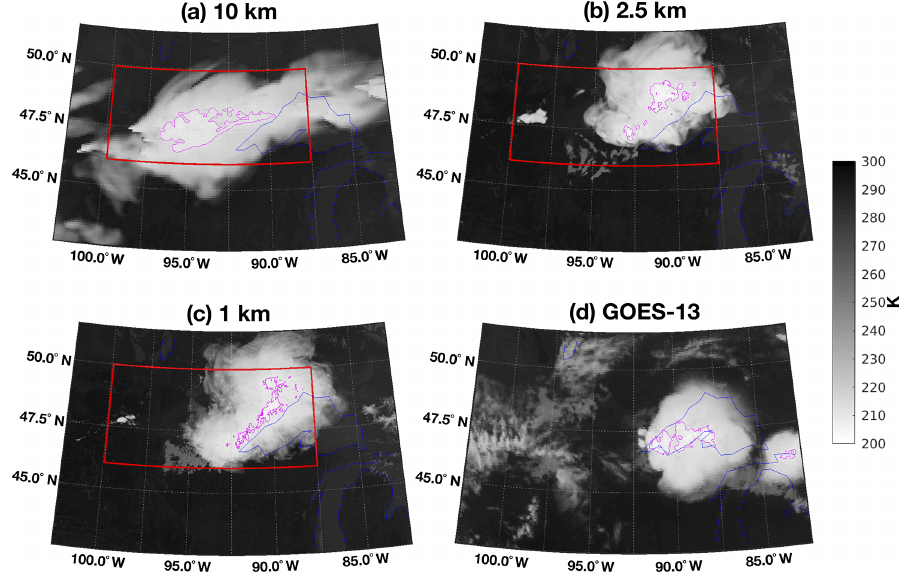
Figure 3. GEM-simulated deep convective clouds compared to satellite observation. Brightness temperatures are simulated using the RRTMG radiative transfer model, from GEM simulations at three resolutions with 10km (02:30UTC, 26 August), 2.5km (23:00UTC, 25 August) and 1km (23:00UTC, 25 August) grid spacing and compared to the brightness temperature of 11.2µm channel of GOES-13 satellite (06:00UTC, 26 August). The red rectangles mark Domain A. The magenta lines highlight the area with a brightness temperature lower than